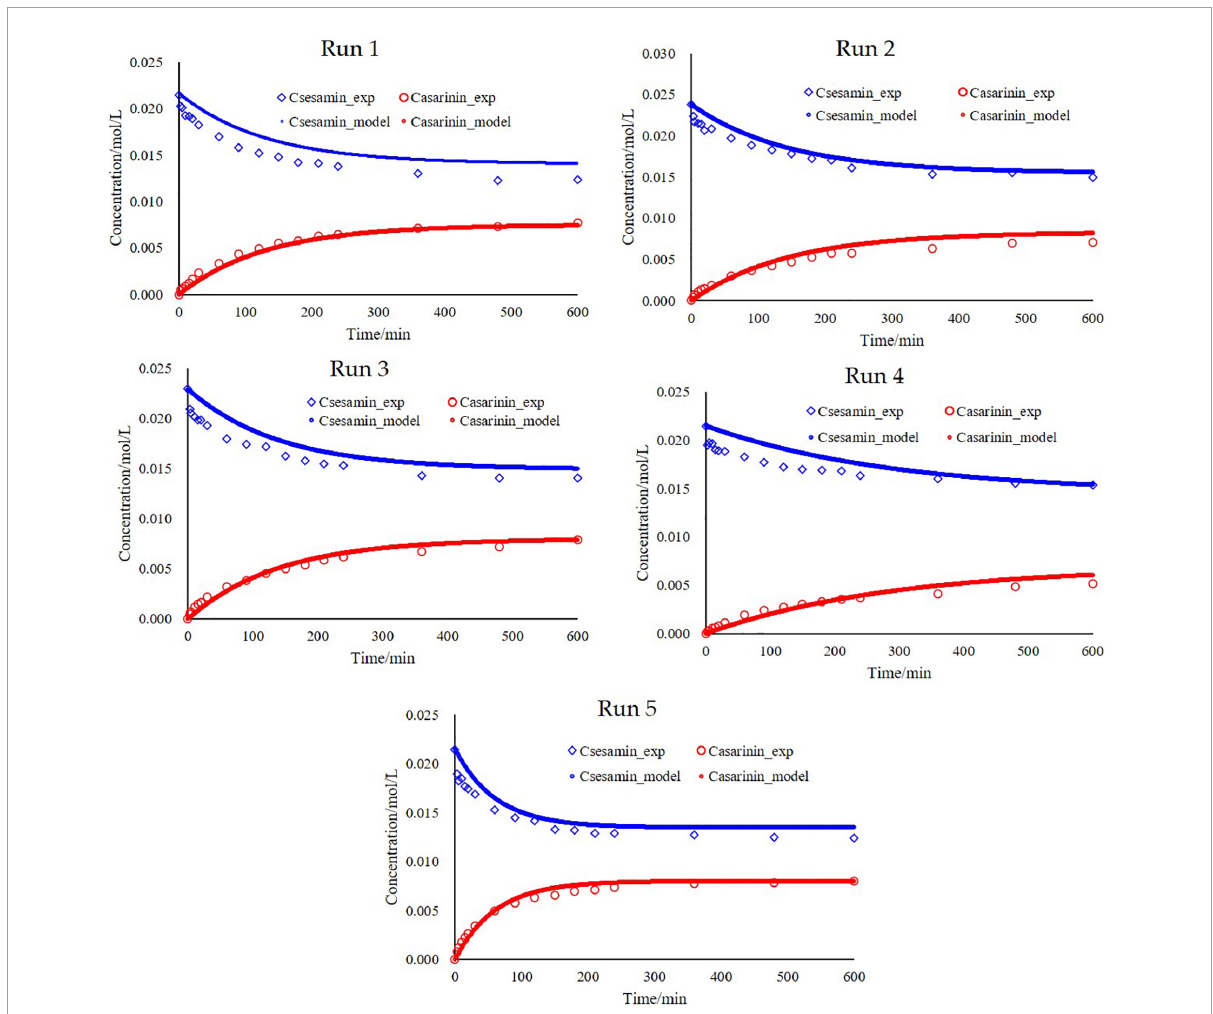
FIGURE6 Fitting the model to the experiments and simulation of C sesamin and C asarinin for experiments 1–5. Run 1 [(C A ) = 21.47 mmol/L with catalyst loading, 1.6%; temperature, 80 ◦ C; rotation speed, 300 rpm and (C B ) = 0 mmol/L]; Run 2 [(C A ) = 23.83 mmol/L with catalyst loading, 1.6%; temperature, 80 ◦ C; rotation speed, 300 rpm and (C B ) = 0 mmol/L]; Run 3 [(C A ) = 22.91 mmol/L with catalyst loading, 1.6%; temperature, 80 ◦ C; rotation speed, 300 rpm and (C B ) = 0 mmol/L]; Run 4 [(C A ) = 21.47 mmol/L with catalyst loading, 1.6%; temperature, 70 ◦ C; rotation speed, 300 rpm and (C B ) = 0 mmol/L]; Run 5 [(C A ) = 21.47 mmol/L with catalyst loading, 1.6%; temperature, 90 ◦ C; rotation speed, 300 rpm and (C B ) = 0